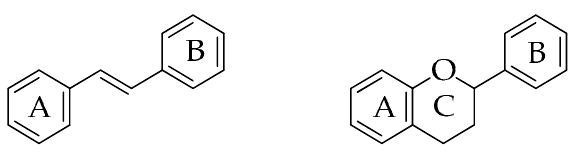
Figure 2. Basic skeleton of stilbenes and flavonoids.